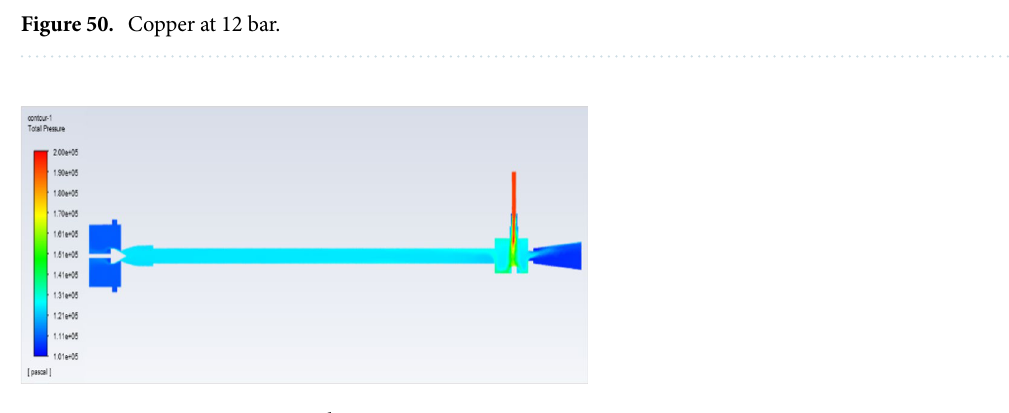
Figure 51. Pressure contours at 2